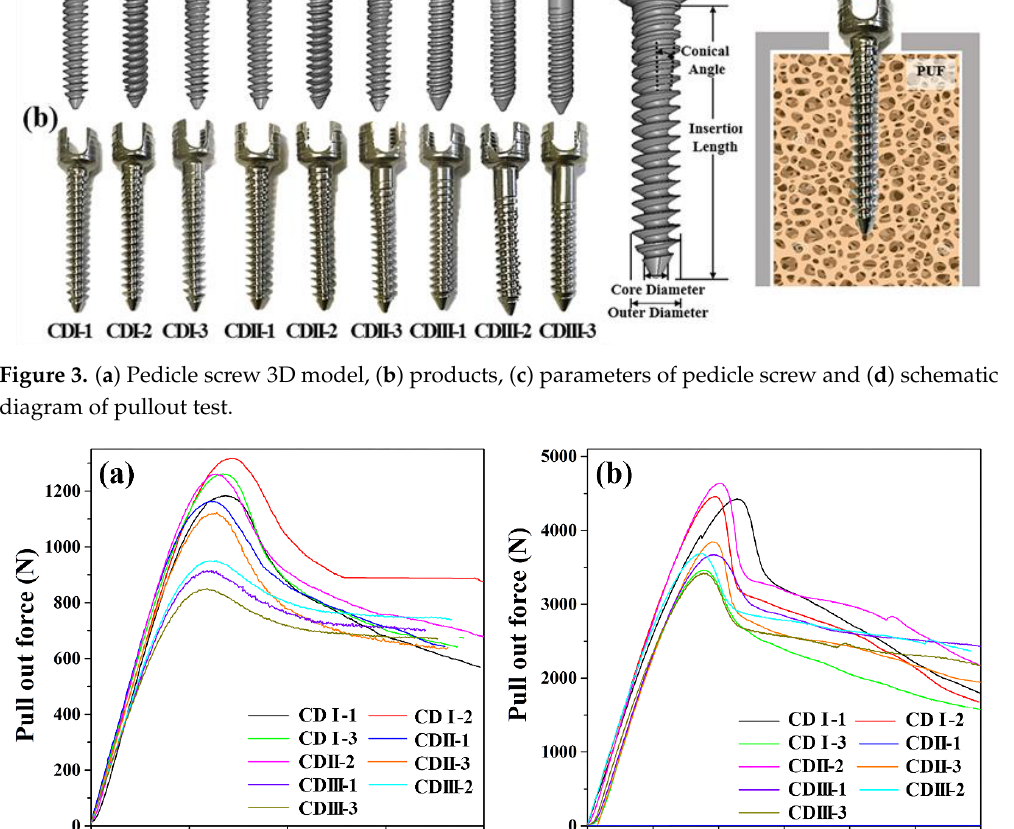
Figure 4. Pullout force–displacement curve of pedicle screws with ( a ) grade 10 and ( b ) grade 20.